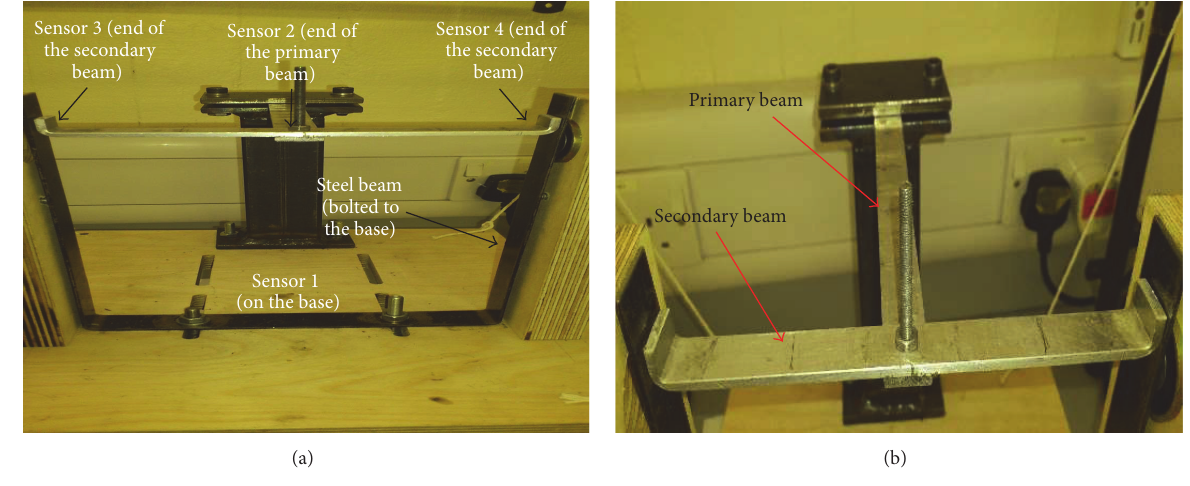
Figure 12: Test rig built for experimental